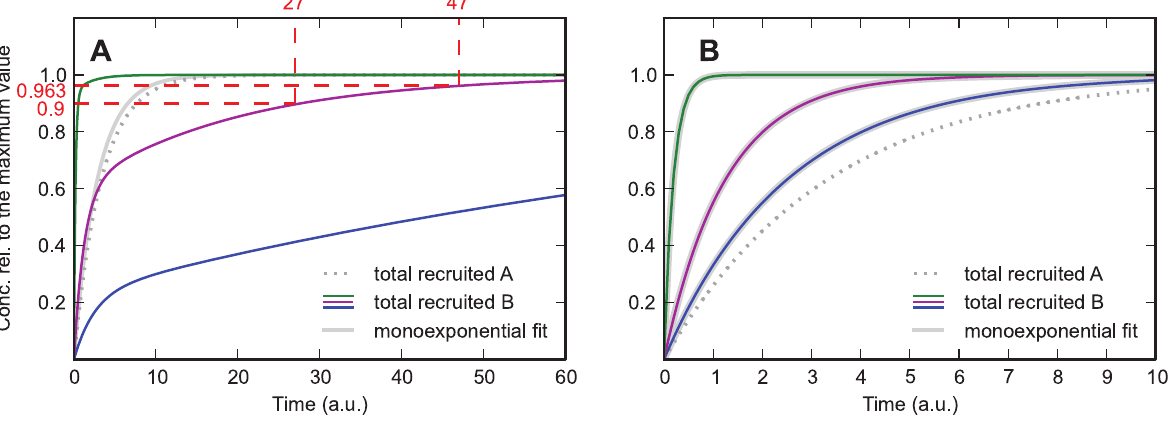
Figure 3. Model in which protein A decreases the association rate of protein B . k (cid:3) ~ 0 : 1 k (cid:3) . Solid lines are for protein B , the dotted line is for protein A . The grey line is a monoexponential fit. The dashed lines top curve. A) k (cid:3) SA z B S z B are used for estimating the rate constants from the curves, giving k (cid:3) much slower, and the slope of the recruitment curve of B (purple curve) decreases faster than would be expected from a monoexponential curve that has a similar initial slope (grey curve). B) same parameters as in A) except k (cid:3)